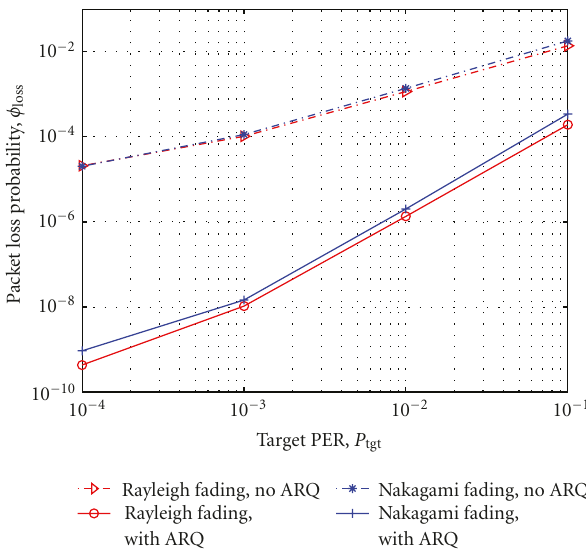
Figure 7: Packet loss probability versus the target PER, I max = 10 dB, = N max r